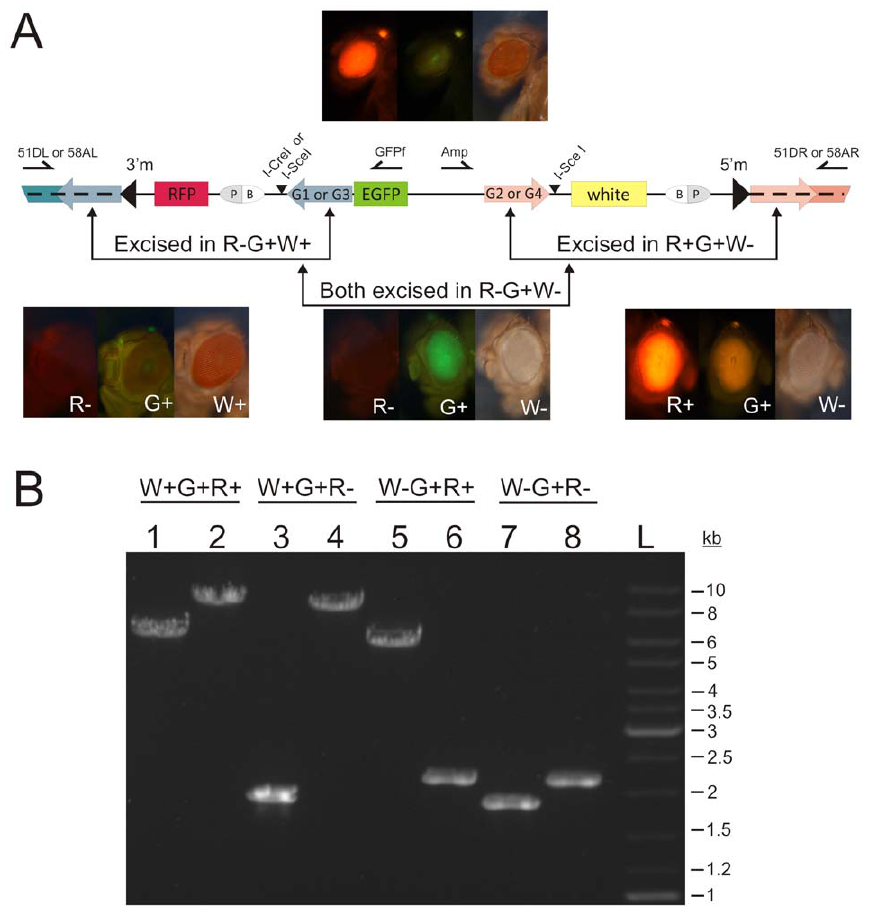
Figure 2. Phenotypes and PCR analysis of vector sequences in line TS51D and their derivatives. a. Combined TS51D, TS51D2xSce and TS58A2xSce schematic structure after integration in landing platform. Arrows above indicate primers. Image inserts show eye phenotypes of flies from TS51D2xSce line and their derivatives. b. Agarose gel with PCR products from indicated primers. Primer pairs 51DL/GFPf were used to analyze to analyze deletion of 3 9 ITR with RFP, Amp/51DR – deletion of 5 9 ITR with white . Primers pairs: lanes 1, 3, 5, 7 – 51DL/GFPf (prediction size of products 5630 or 1881 bp); lanes 2, 4, 8, 10 - Amp/51DR (7640 and 2167 bp). Size of PCR products for R-G + W + , R + G + W- R-G + W- flies agree with the expected size for SSA-pathway repair ( Supplementary Table S3